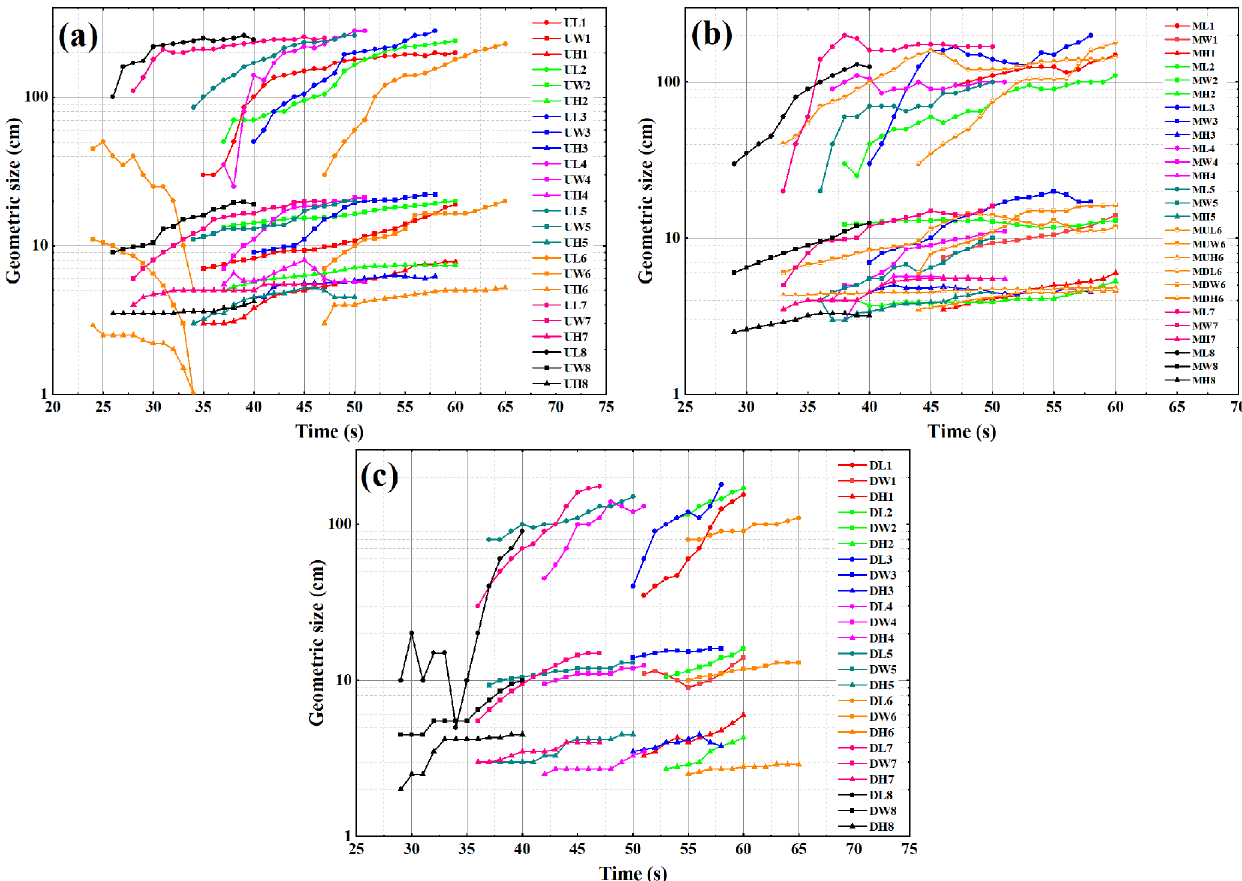
Figure 6. The lengths, widths, and heights of the boulder bars: (a) sizes of the boulder bars near the upstream reaches; (b) sizes of the boulder bars near the middle reaches; (c) sizes of the boulder bars near the downstream reaches. Notation: L, W, and H represent the length, width, and height of the boulder bar, respectively. Digits 1 to 8 indicate T1 to T8 tests, respectively. For example, MUL6 indicates the length of the boulder bar near the middle-upstream reaches for the T6